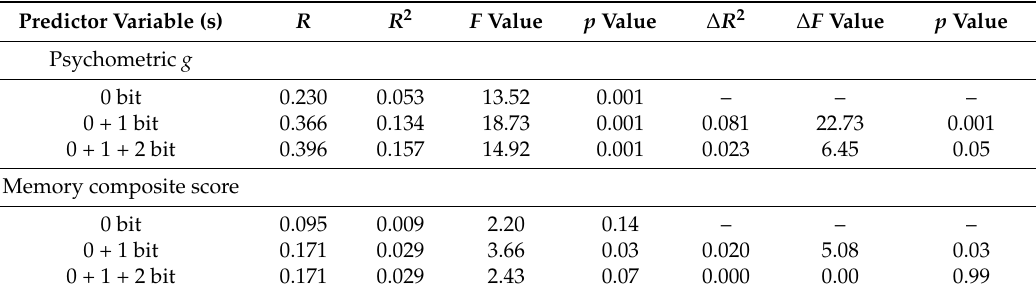
Table 5. Results of stepwise regression analyses for the prediction of psychometric g and the memory composite